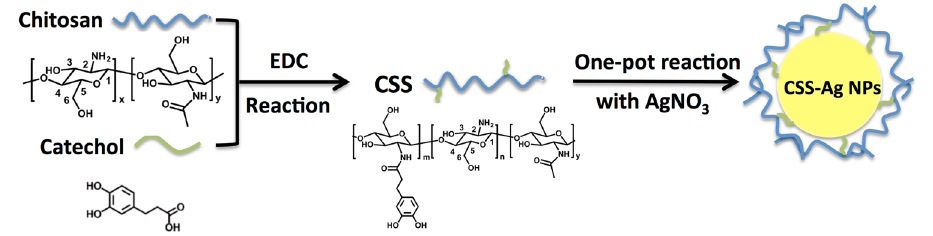
Figure 1. Schematic representation for the green synthesis of CSS-Ag NPs. CSS was synthesized by the conjugation of bio-inspired catechol to chitosan through EDC chemistry procedure. As a stabilizing and reducing agent, CSS was added into Ag NO 3 solution to prepare CSS-Ag